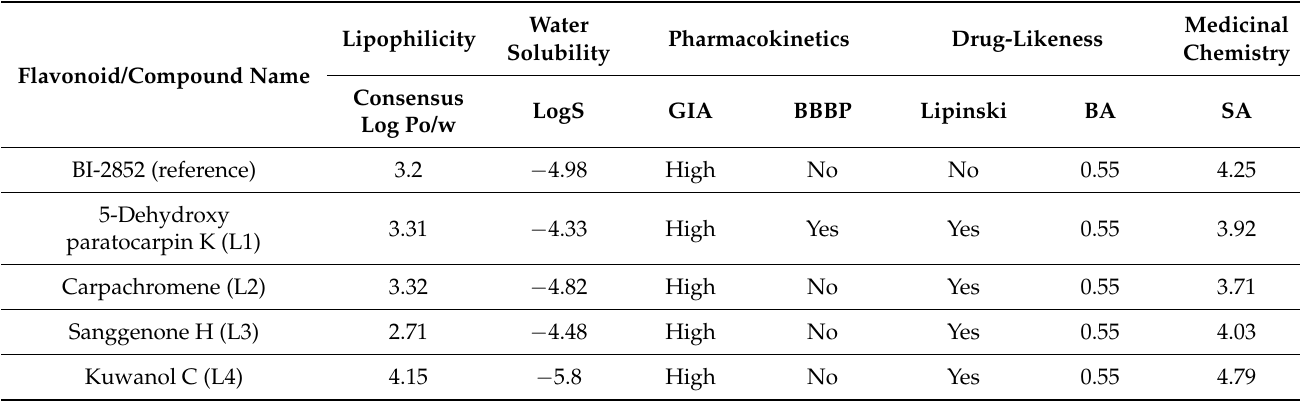
Table 2. Lipophilicity, hydrophilicity, pharmacokinetics, drug-likeness and medicinal-chemistry properties of 4 lead